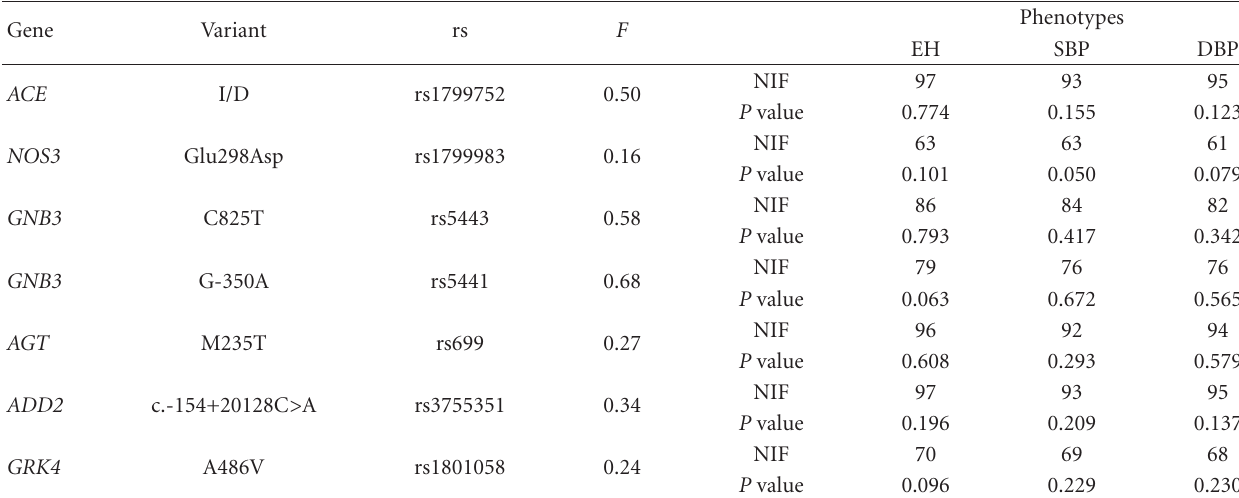
Table 2: FBAT analysis for blood pressure-related traits in quilombos .